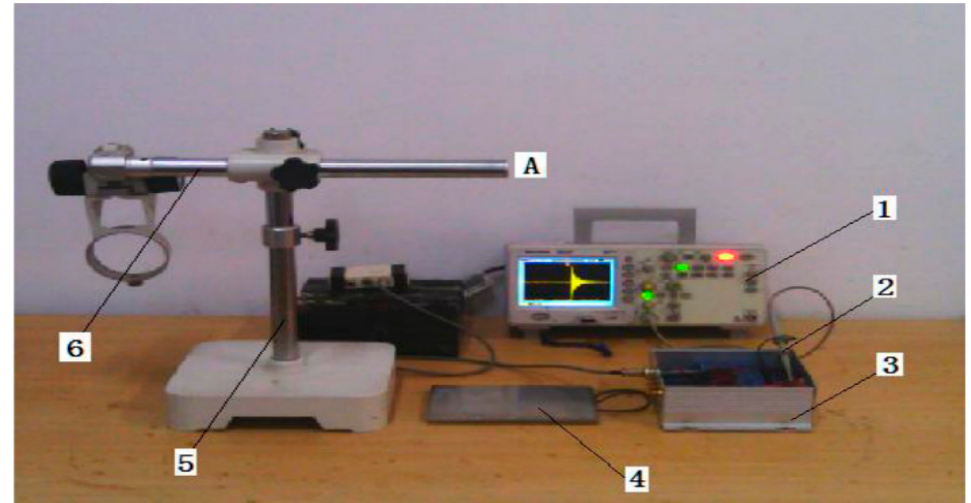
Figure 14. Single grain impact experimental system. A—grain release point, 1—digital storage oscilloscope, 2—probe, 3—signal processing circuit, 4—grain loss sensor, 5—support bar, 6—height adjustment bar [50].